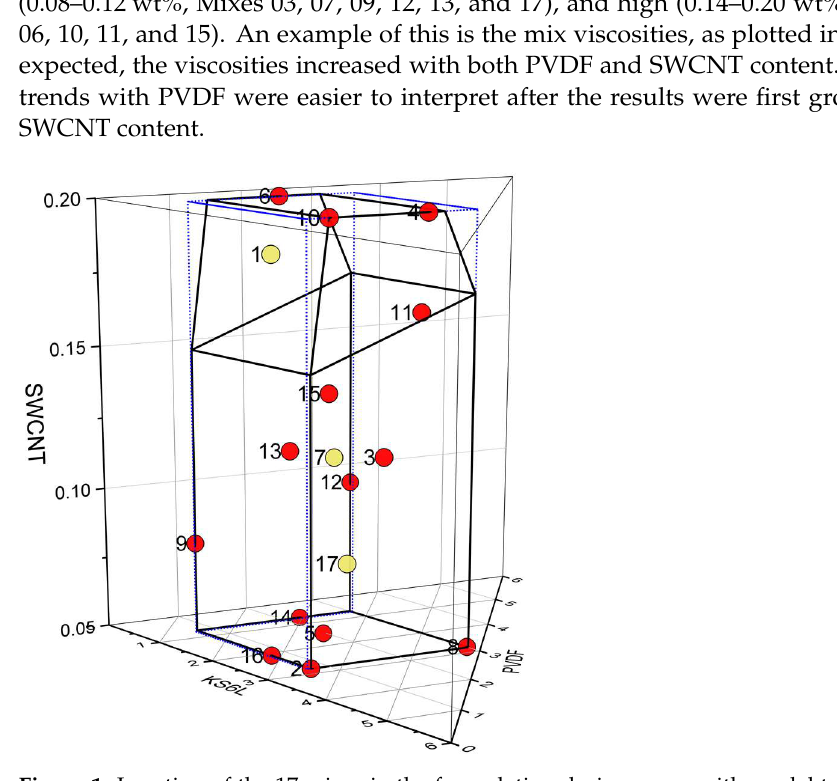
Figure 1. Location of the 17 mixes in the formulation design space with model training (red) and model testing (yellow) points.